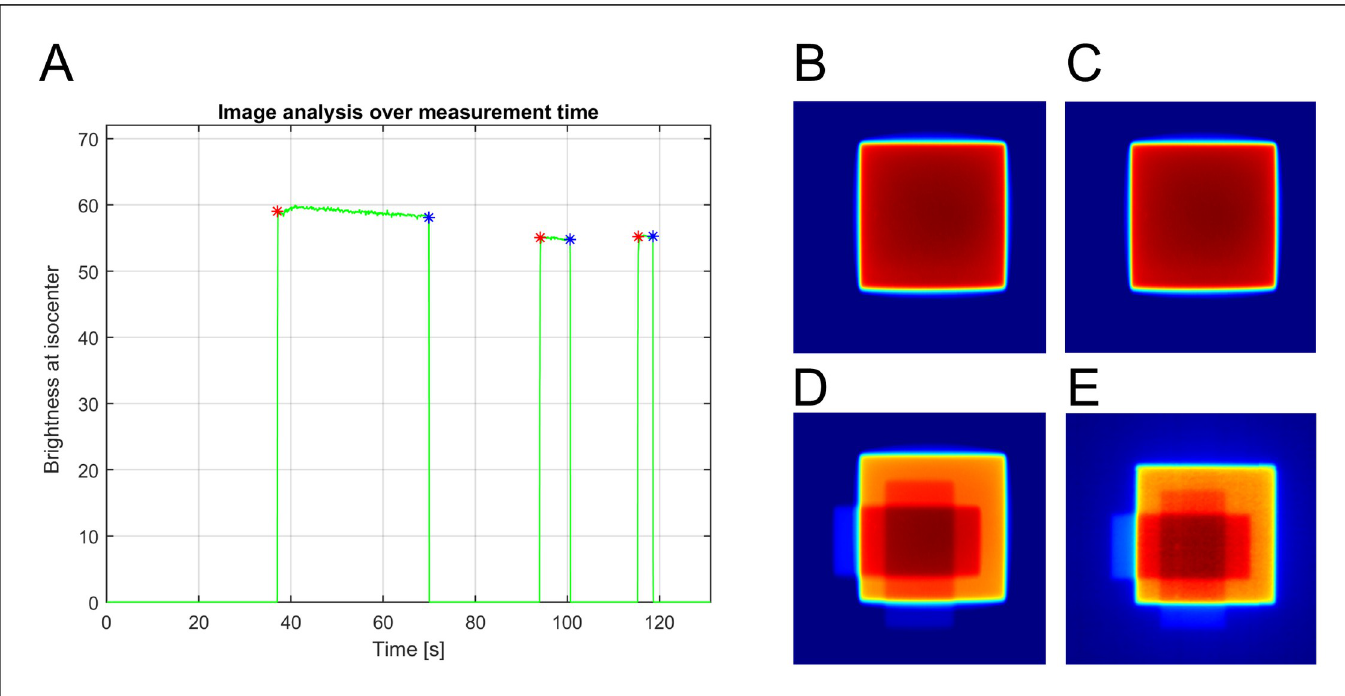
Fig 14. (A) Scintillation signal over time for a simple intensity-modulated plan (field type 1). The accumulated 2D dose distribution of the TRMLSD at (B) 81.6, (C) 110.4, and (D) 127.2 s. (E) 2D dose distribution of the EBT3 film.